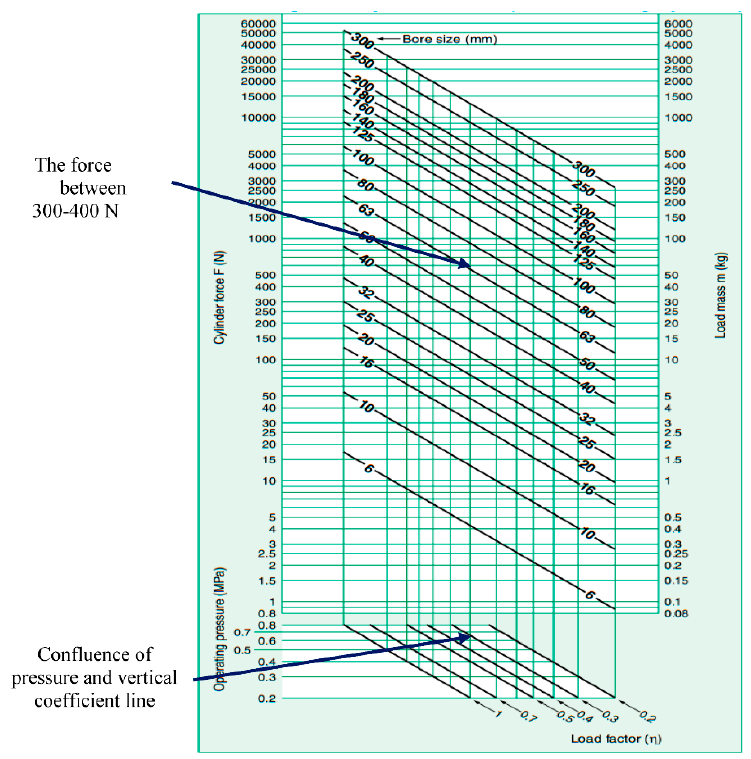
Figure 14. Pneumatic jack bore size selection graph based on the applied force, vertical operating coefficient, and operating pressure.